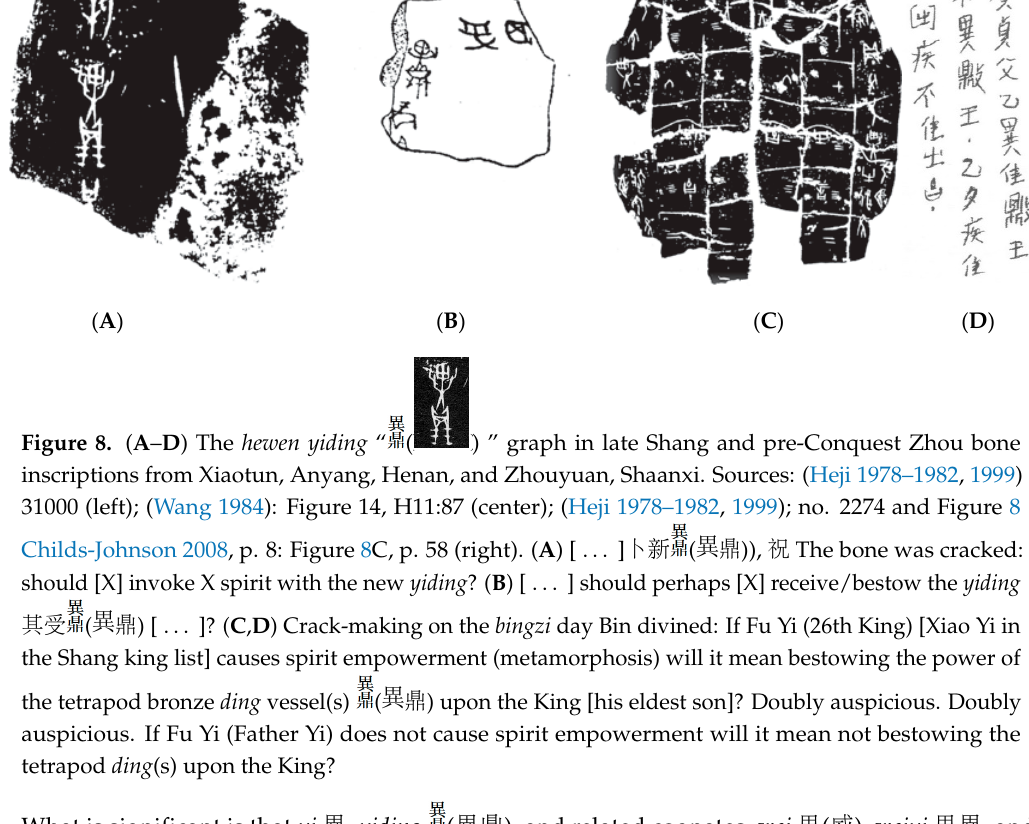
Figure 1. Masked semi-human figures with arms raised. ( A ) Yi 異 graph; ( B ) Displayed yi image, probably Kui; ( C ) Simplified displayed yi image.